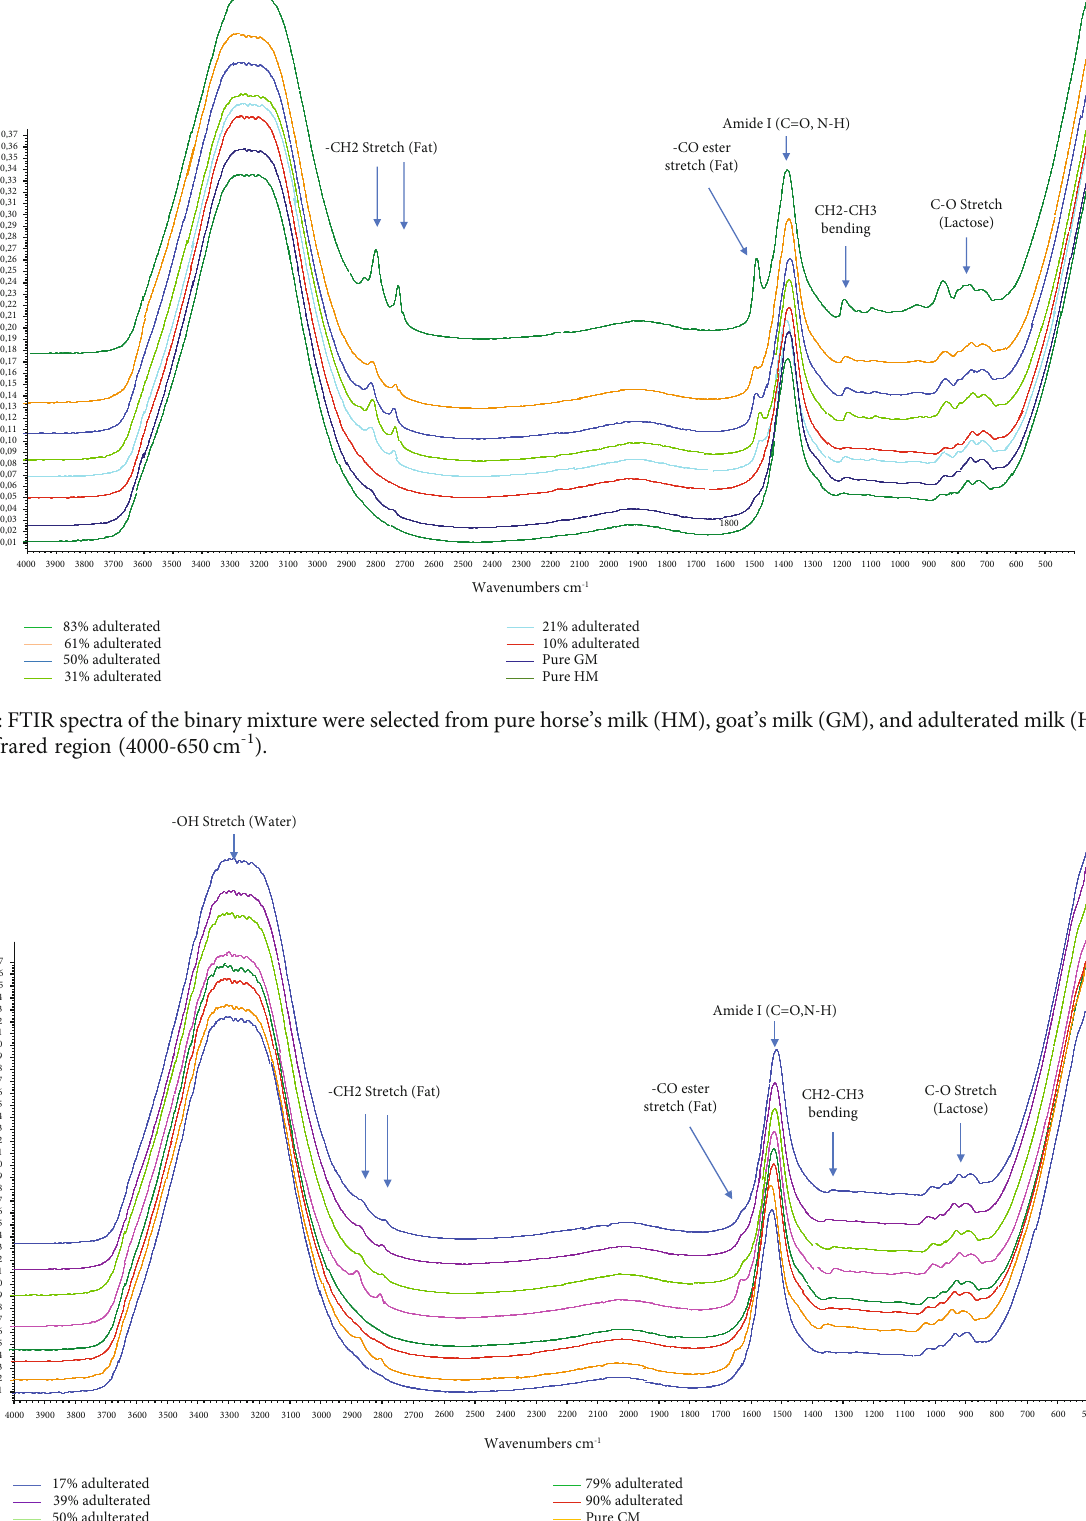
Figure 4: FTIR spectra of the binary mixture were selected from pure horse ’ s milk (HM), cow ’ s milk (CM), and adulterated milk (HM-CM) in the infrared region (4000-650cm -1